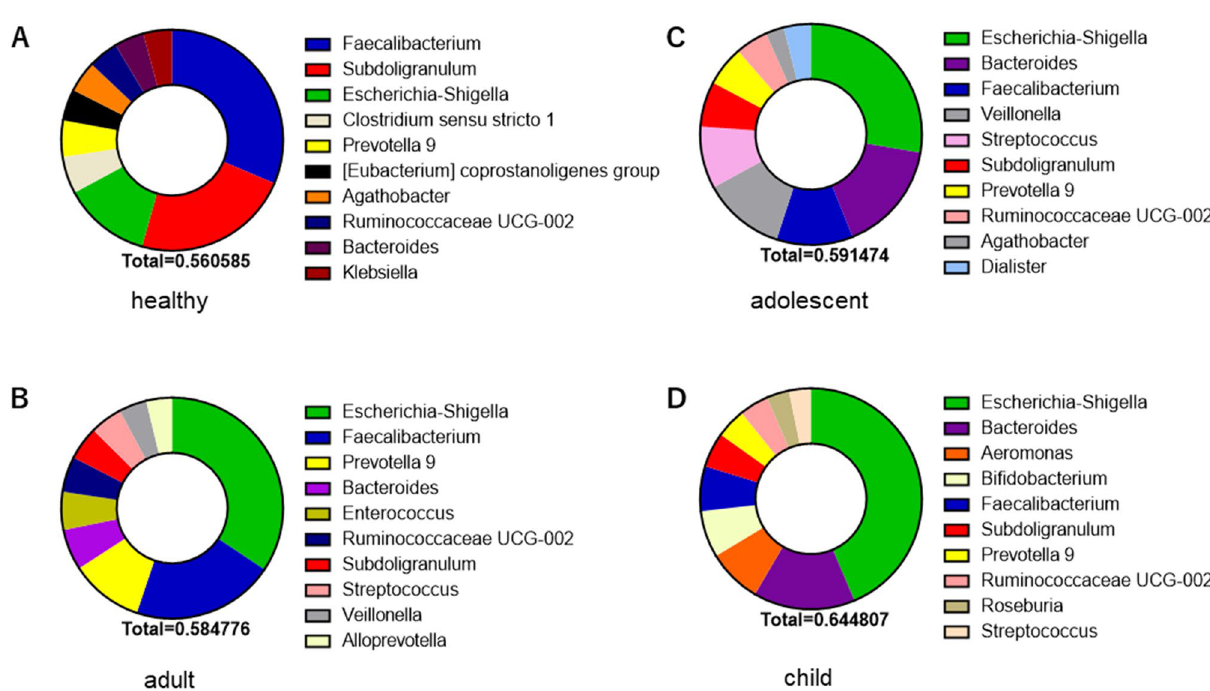
Figure 3. Taxonomic profiles (genus) of fecal bacteria in patients with diarrhea and healthy controls. Top 10 relative abundance of fecal taxa at the phylum level in healthy adult controls ( A ) and patients with diarrhea; adults ( B ), adolescents ( C ), and children ( D